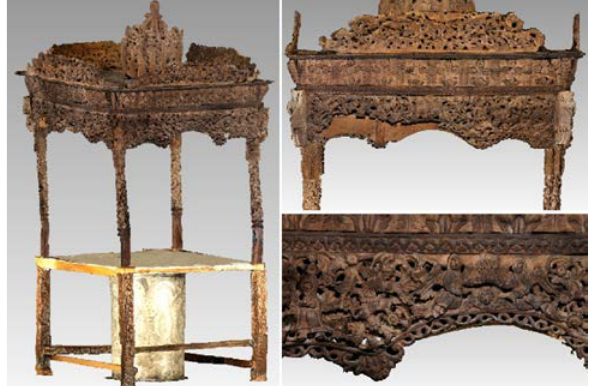
Figure 3 . 3D view (left) and zoom-in views (right) of the Ciborium of the church of St. Charalabos.